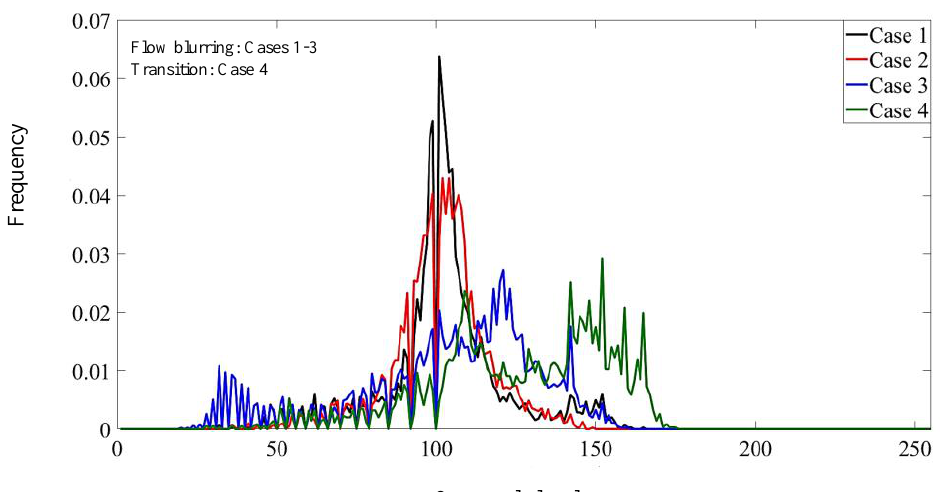
Figure 7. The gray distribution curves of the two-phase flow images under different water flow rates: the air flow rate, tube-hole distance and orifice diameter are 80 L/min, 1 mm and 5 mm, respectively. For cases 1 to 4, the water flow rates are 100 mL/min, 200 mL/min, 400 mL/min and 600 mL/min, respectively.